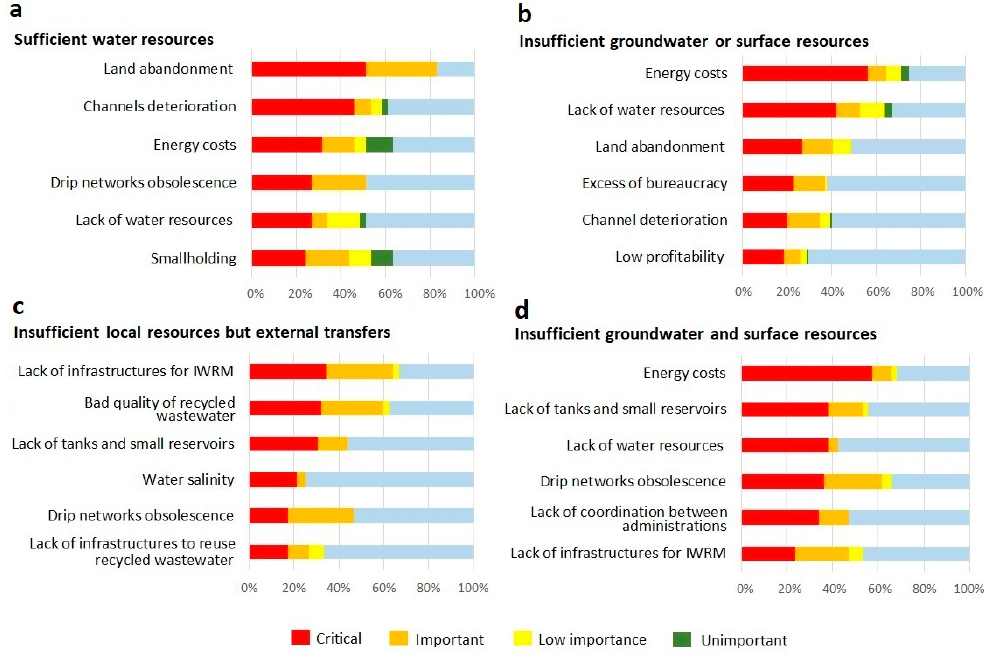
Figure 3. Problem assessment according to water resource availability: evaluated in terms of percentage of total votes. ( a ) Sufficient water resources; ( b ) Insufficient groundwater or surface resources; ( c ) Insufficient local resources but external transfers; ( d ) Insufficient groundwater and surface resources.